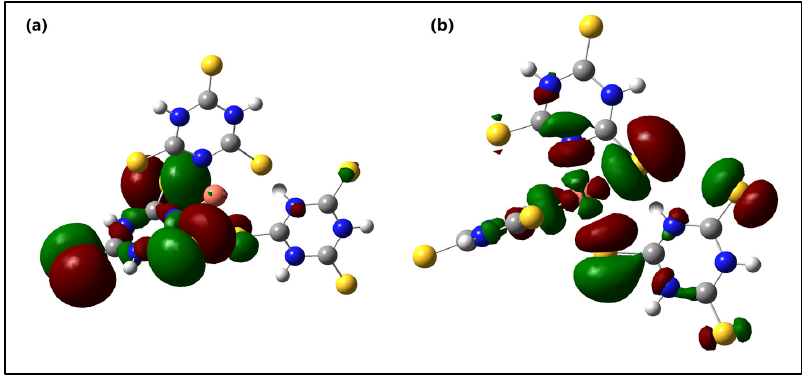
Figure 9. Molecular orbital surfaces for the ( a ) HOMO and ( b ) LUMO of the s -Cu-TTC.